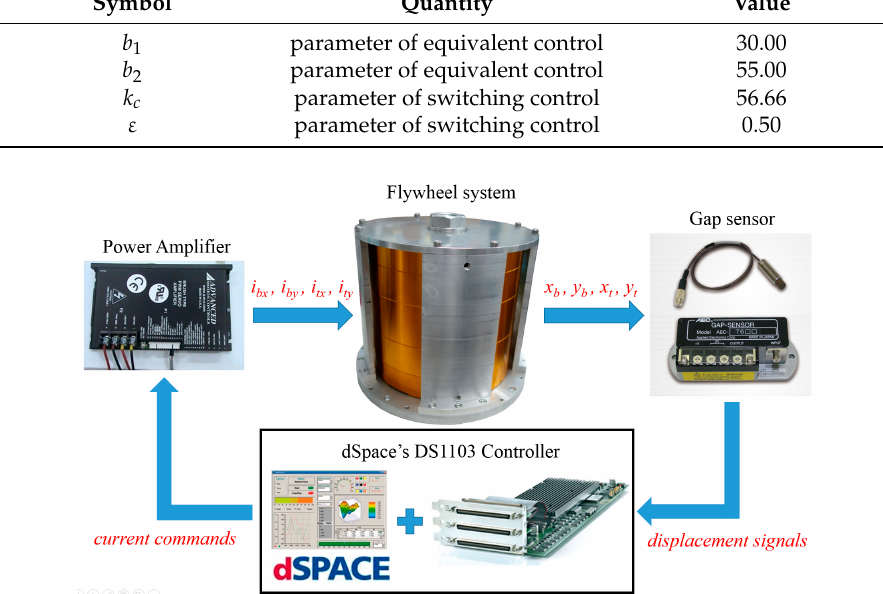
Figure 16. Block diagram of the experiment setup.